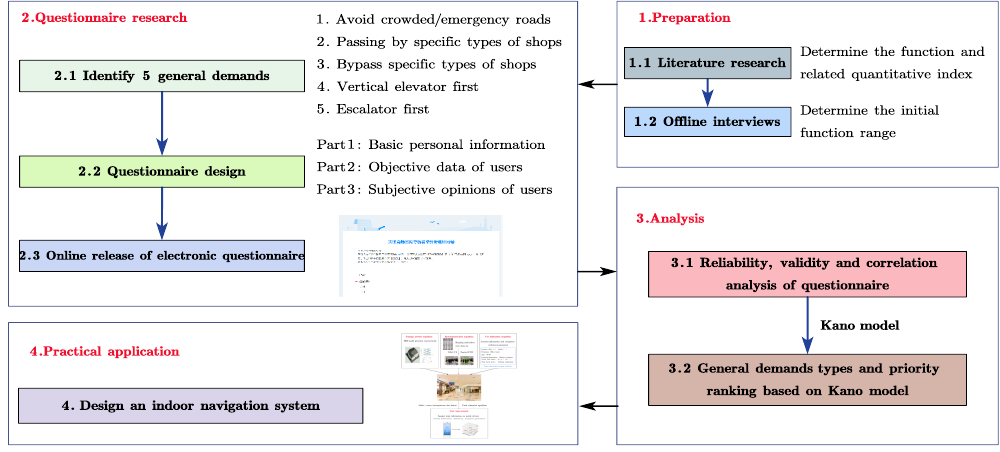
Figure 1. Method of this paper.